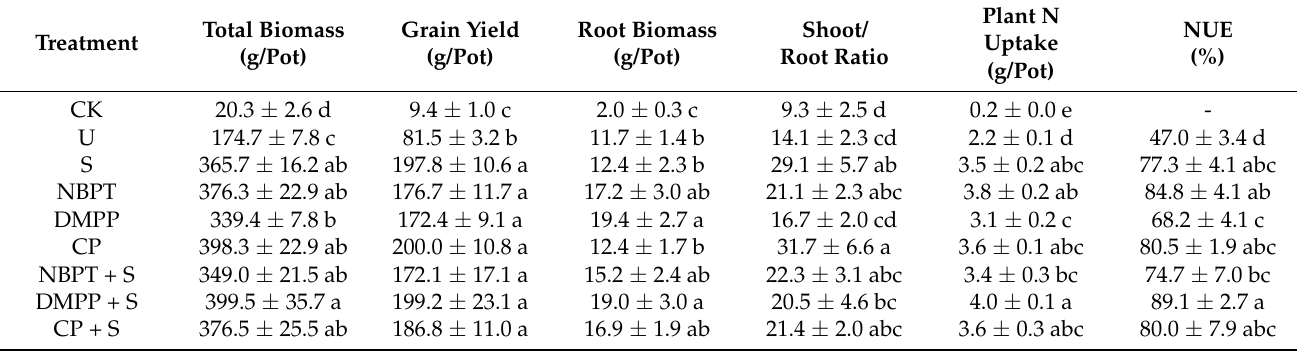
Table 5. Maize yield, shoot/root ratio and nitrogen harvest